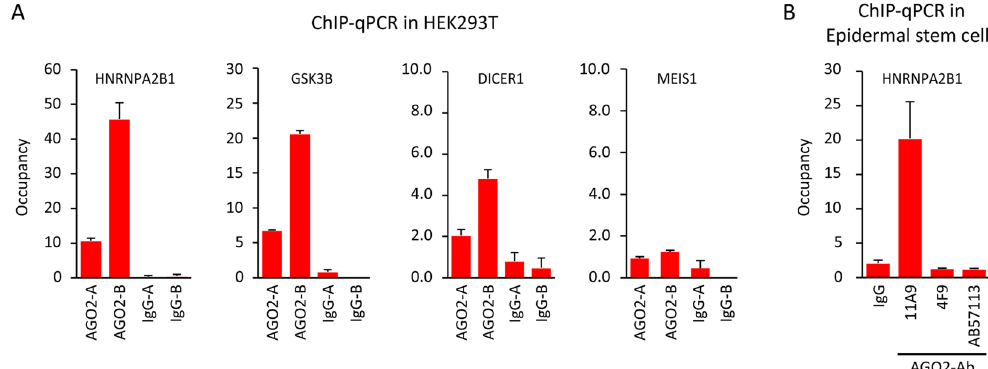
Figure 3. The anti-AGO2 11A9 ChIP enriched loci seem not cell type specific or AGO2 specific. ( A ) ChIP- qPCR in HEK293T cells at the same loci as in Fig. 1F. Meis1 is a negative region. ( B ) ChIP-qPCR in epidermal stem cells with anti-IgG and 3 different AGO2 antibodies at the HNRNPA2B1 locus. Occupancy represents enrichment over a heterochromatic region, A and B represent biological replicates and error bars represent standard deviations of 3 technical